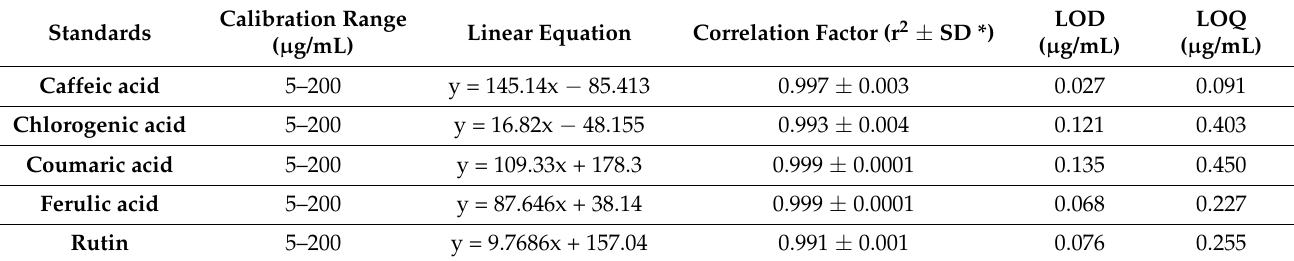
Table 2. Calibration values for standards.